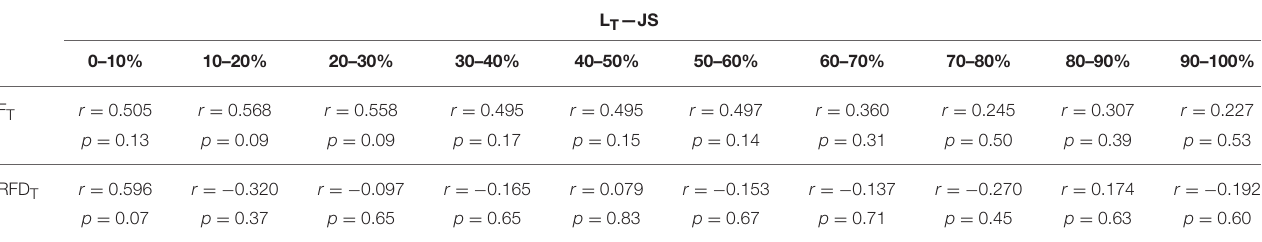
TABLE 4 | Relationship between quadriceps tendon length (L T ) and patellar tendon force magnitude (F T ) and rate (RFD T ) during a loaded jump squat